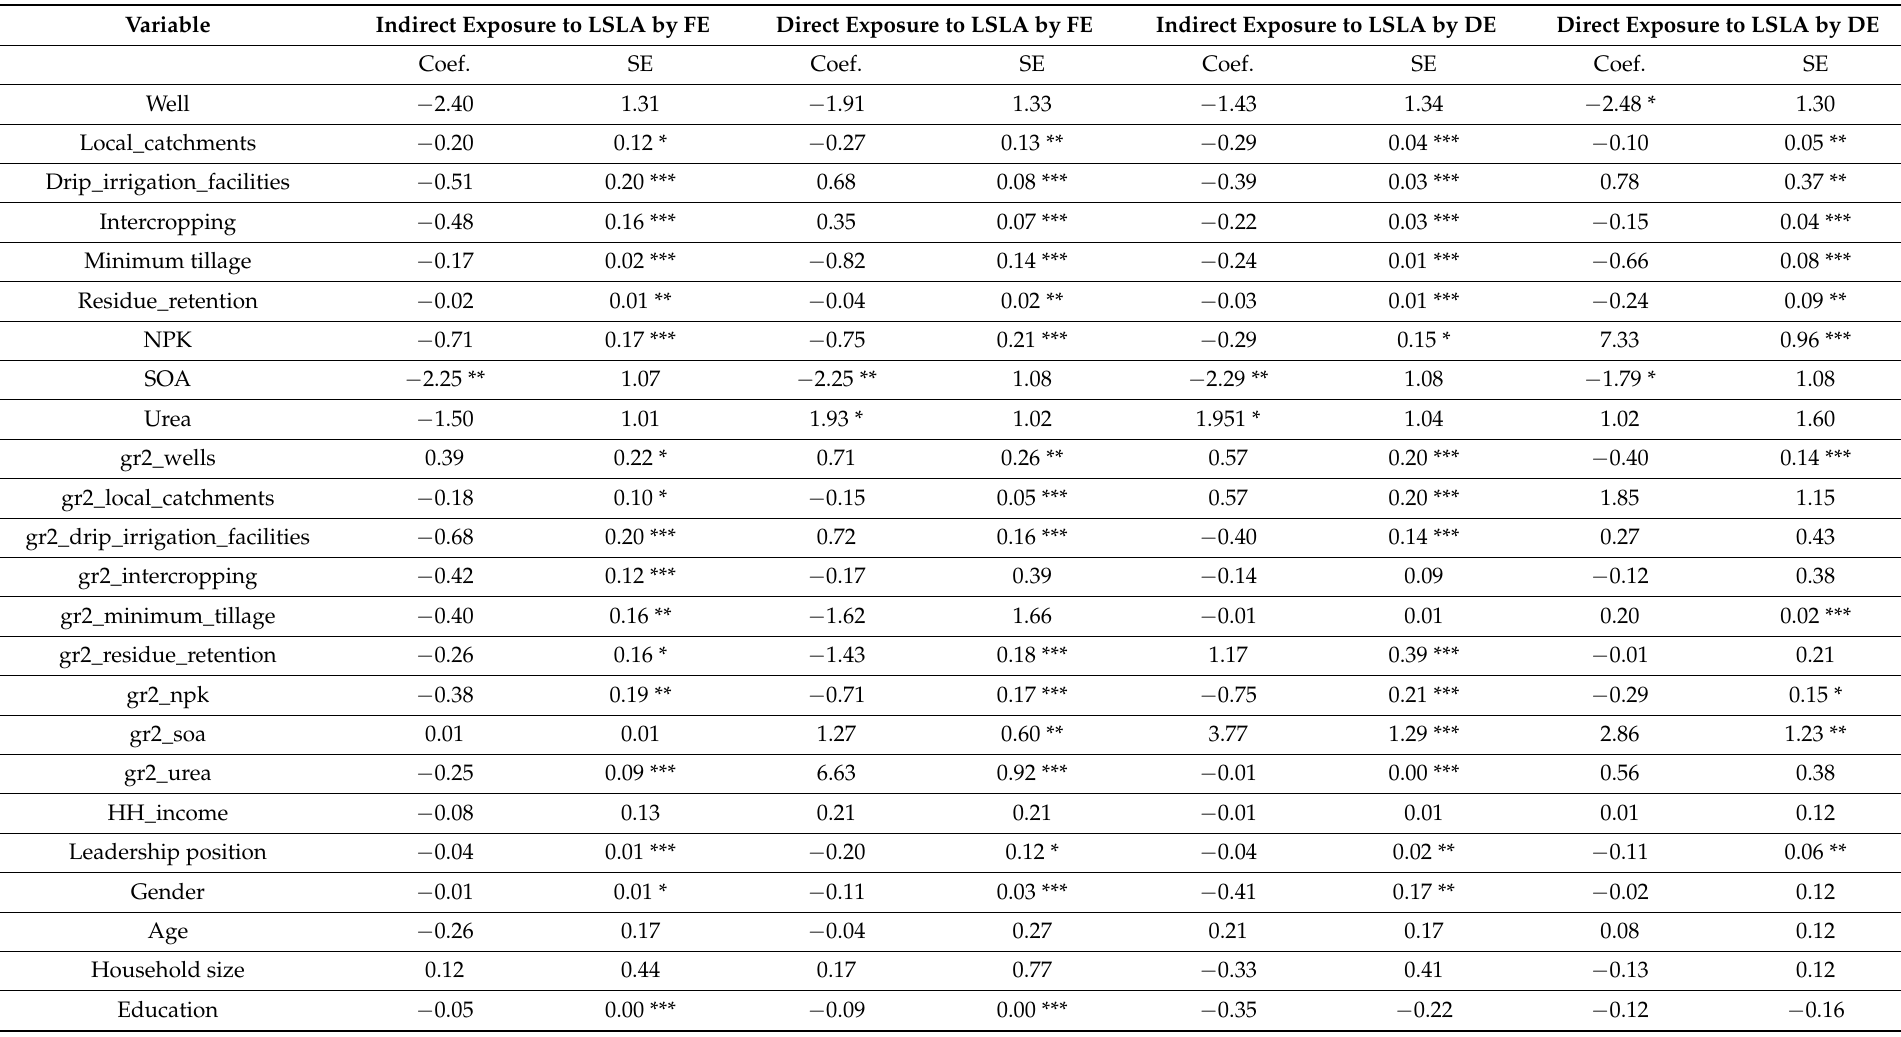
Table 3. Multinomial logit estimates of determinants of exposure to